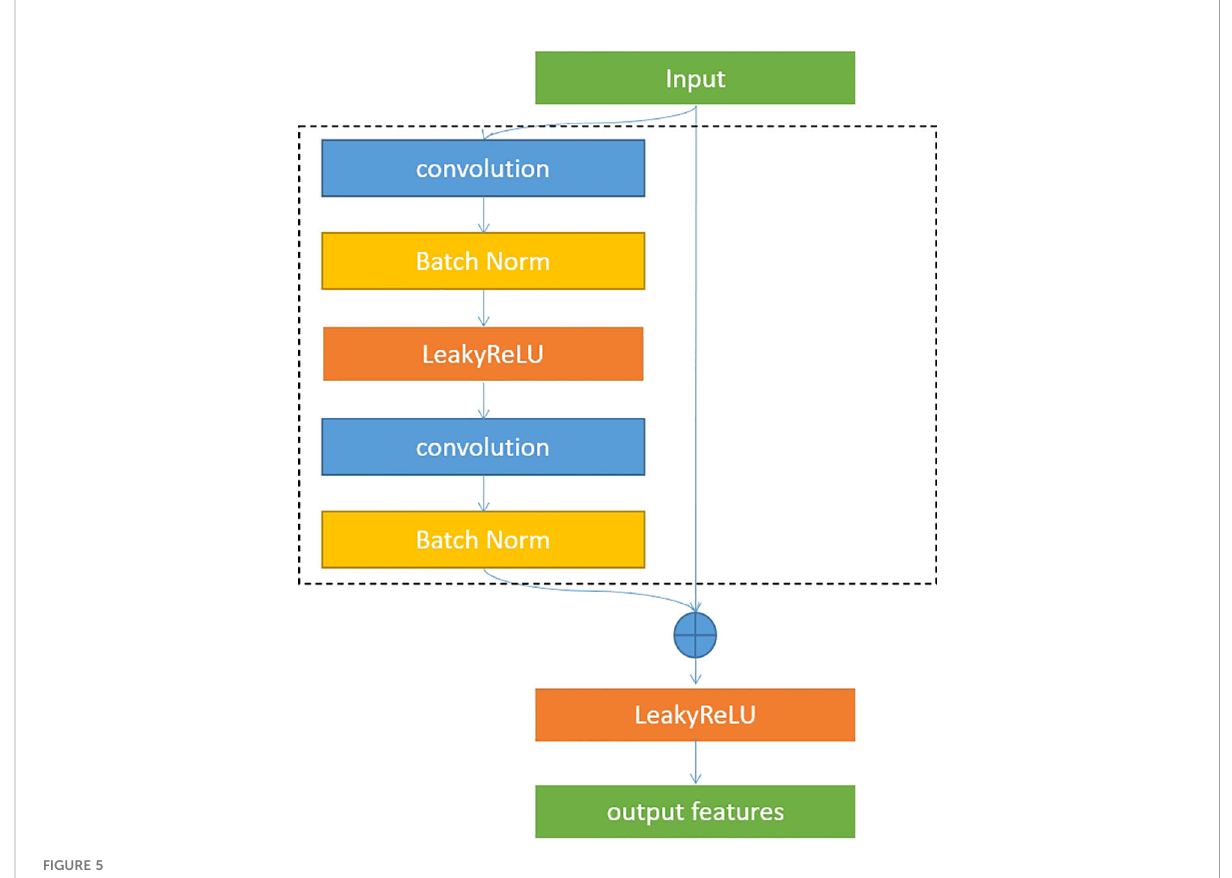
FIGURE 5 Residual